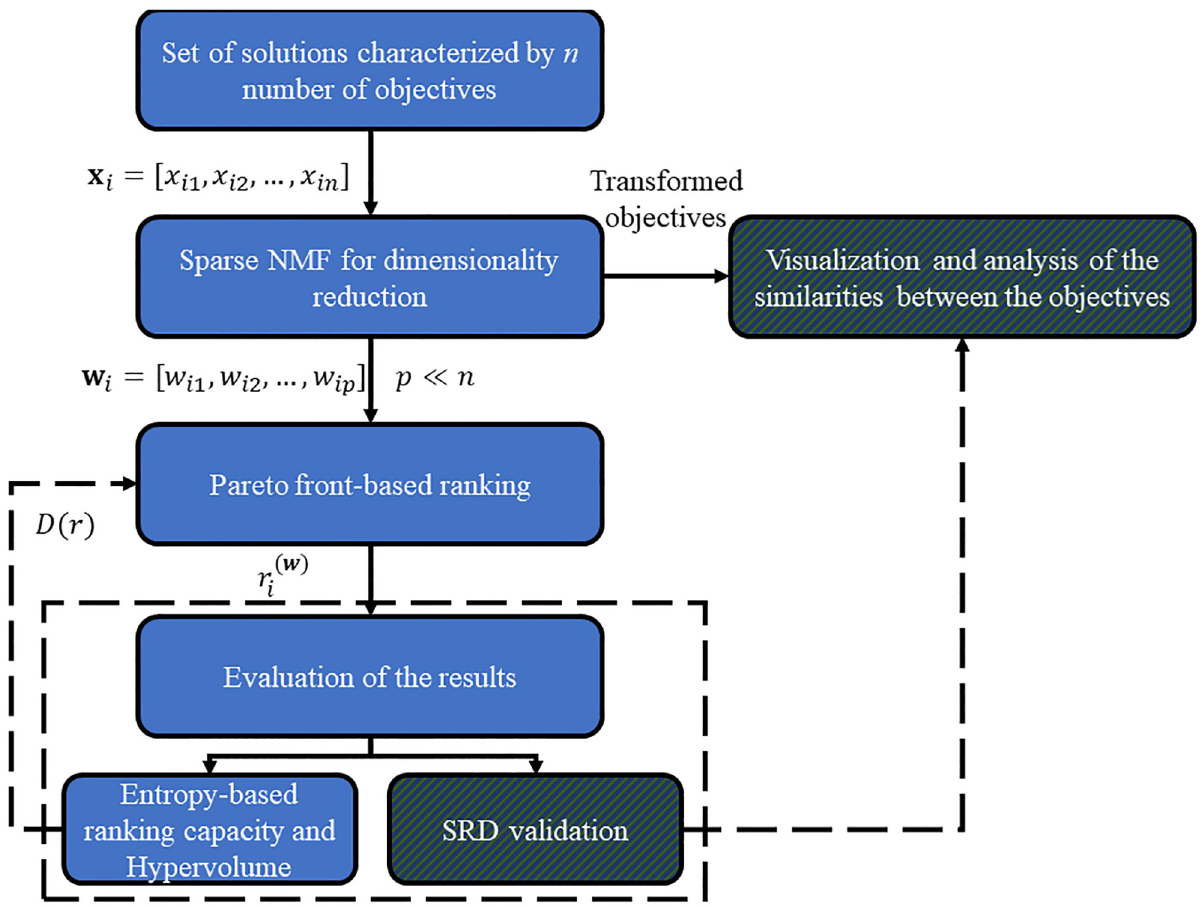
Fig 2. Flowchart of the non-negative matrix factorization-based many -objective optimization method. The input of the workflow requires a dataset containing N number of solutions ( x ) and n objectives. The sparse NMF reduces the objectives to a p amount ( p < < n ). Information for both the solutions and objectives is attained. The objectives are compared, and the Pareto front is applied to the solutions in the low-rank representation of the objective space (the reduced notation for x is denoted by w ). A solution’s rank is established in the lower-dimensional space as r ( w ) . The Pareto front is evaluated through the application of Entropy, and Hypervolume ( i.e. , high saturation and being far from the ideal front may show that the Pareto front is underperforming). The analysis workflow also aims to uncover the relationships between the objectives: the information uncovered from the sparse NMF is verified by Sum of Ranking